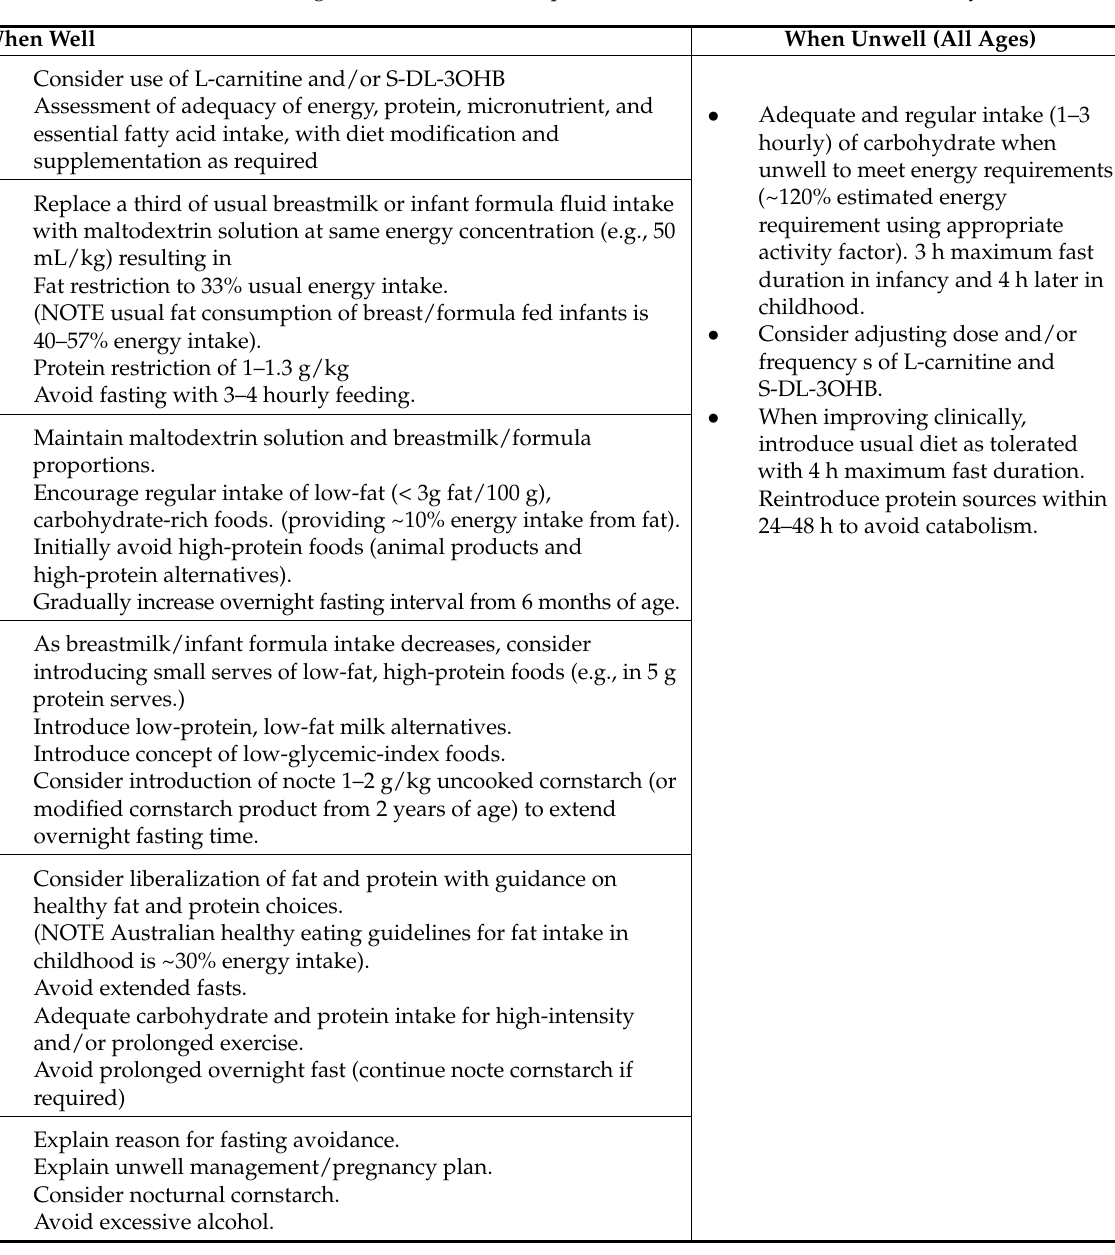
Table 3. Practice guidelines for cohort of patients identified with HMGCL